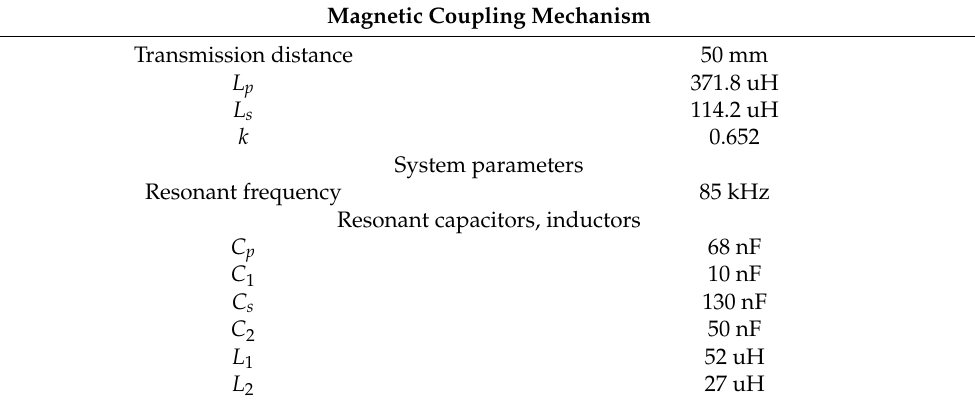
Table 3. WPT system parameters.